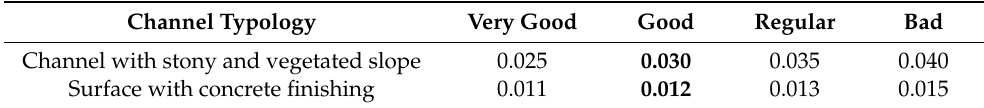
Table 10. Adopted roughness coefficient (Source: [31]). Channel Typology Very Good Good Channel with stony and vegetated slope